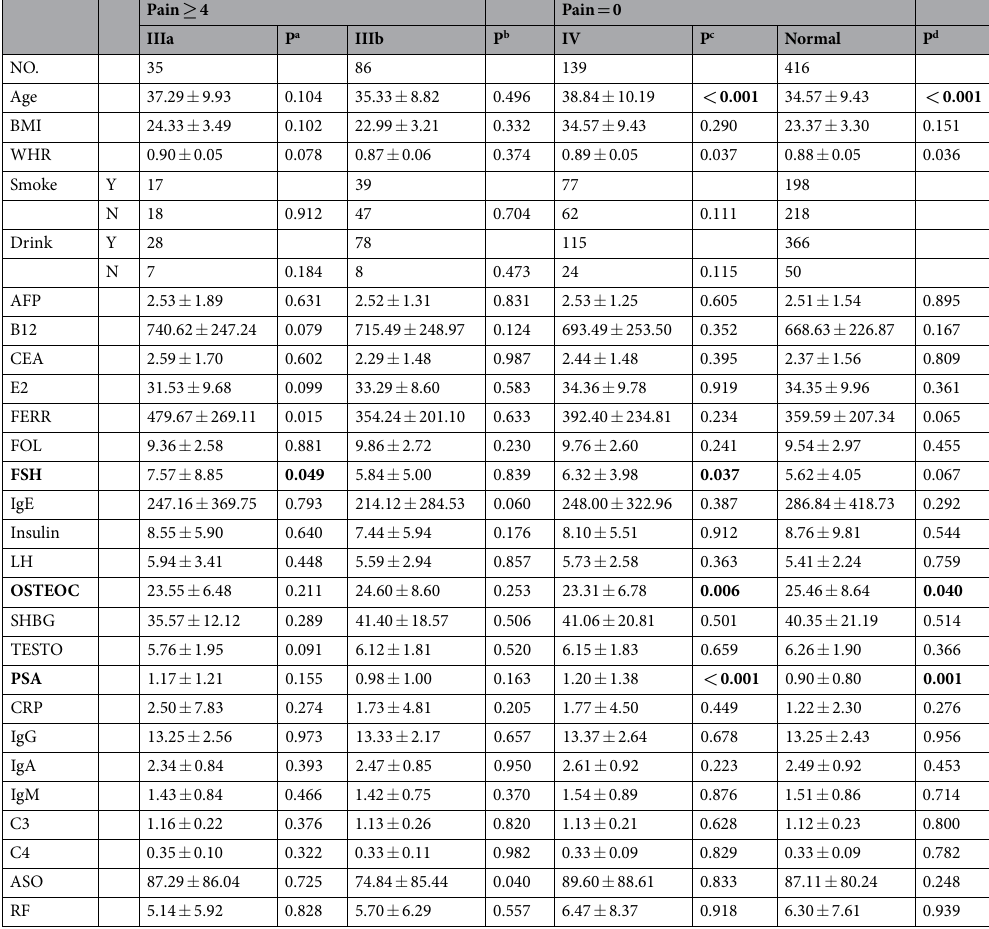
Table 3. The baseline features of IIIa, IIIb, IV and Normal controls on the basis of National Institute of Diabetes and Digestive and Kidney Diseases (NIDDK) classification system. * a The T test between IIIa and Normal group; b The T test between IIIb and Normal group; c The T test between IV and Normal group; d One-Way